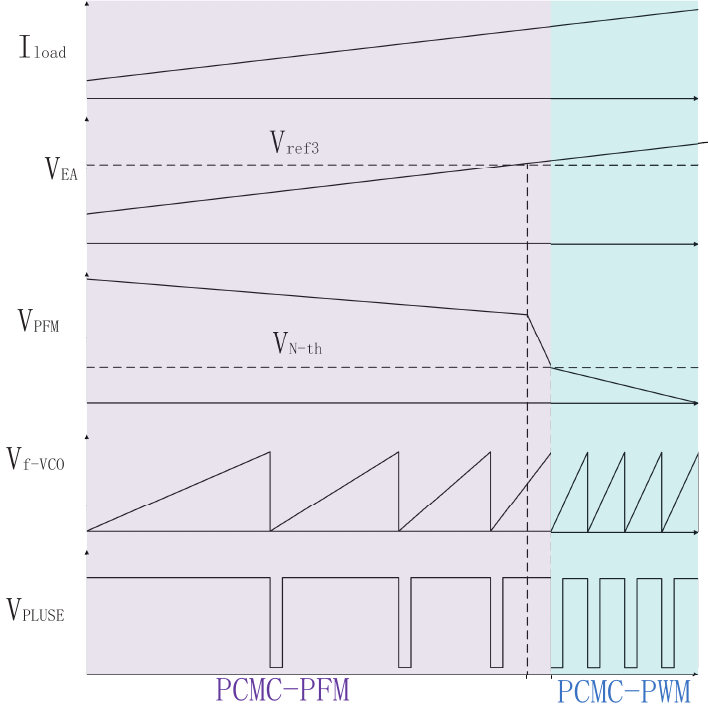
Figure 5. The correspondence curves between V EA , V PFM and V PLUSE when the system is smoothly switched from PCMC-PFM mode to PCMC-PWM